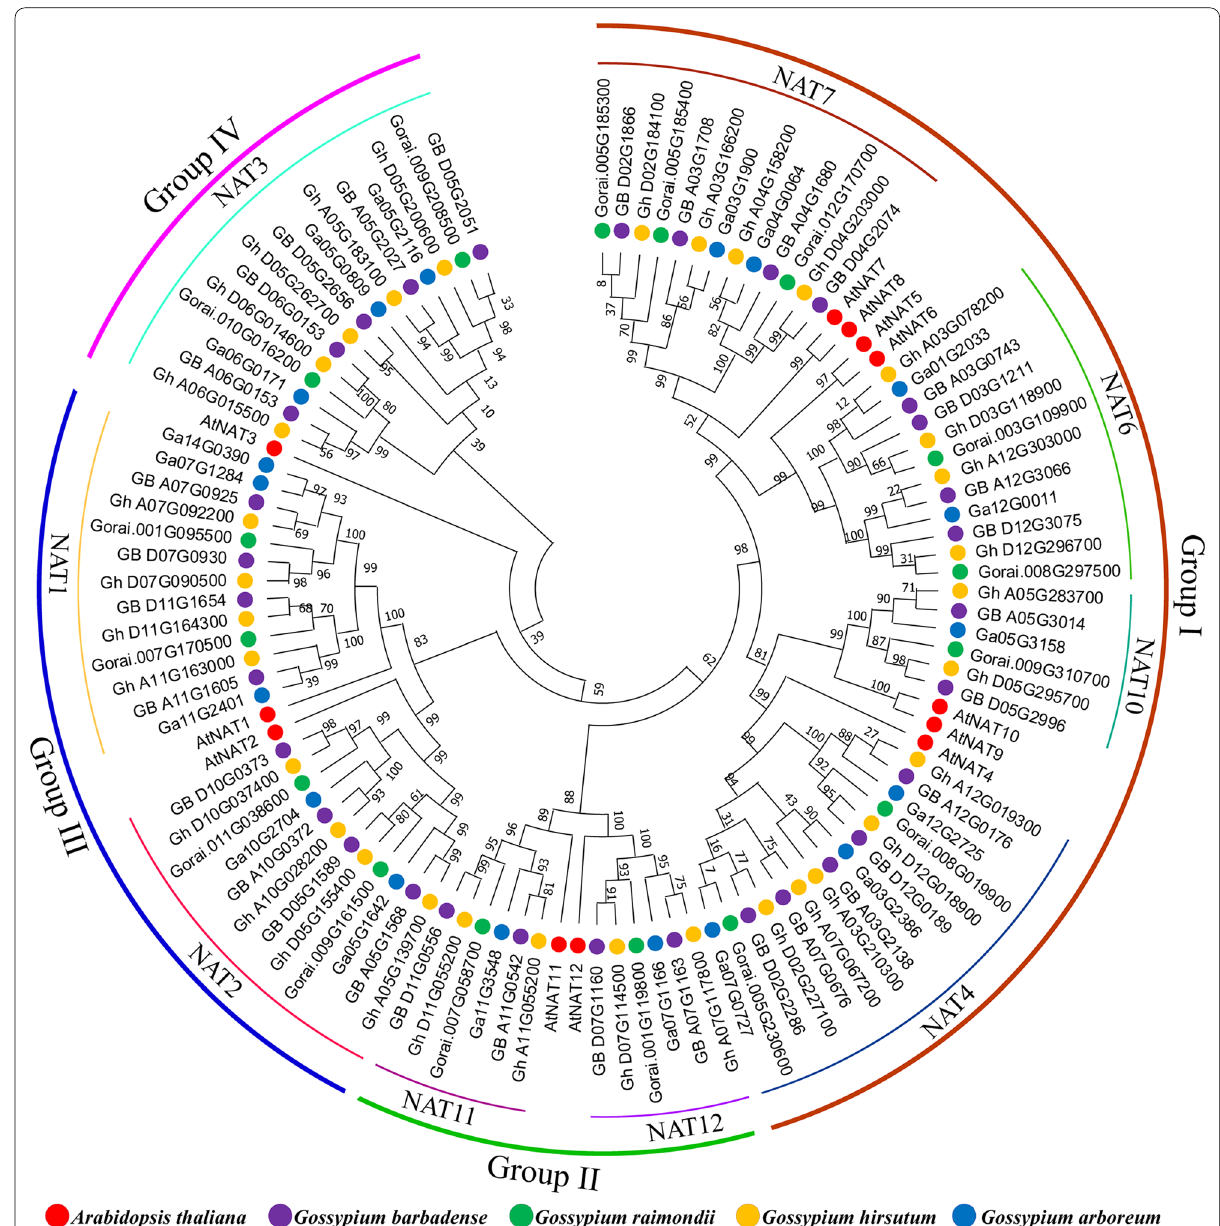
Fig. 1 Phylogenetic tree of the NAT family proteins in different plant species. The phylogenetic tree of NAT proteins was constructed using the Neighbor Joining method. NAT proteins were clustered into four